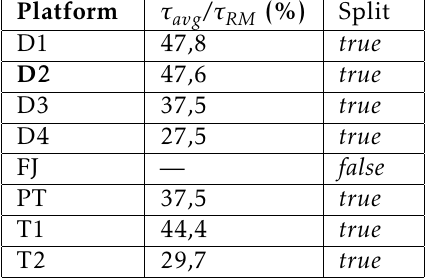
Since most of the platforms set the value split to true the region is splitted. The new region structure is depicted in the central part of Figure 12. There is only one platform staying at the old region, this is RegionMaster. The remaining nodes join the new region with D 2 promoted to be the new RegionMaster.